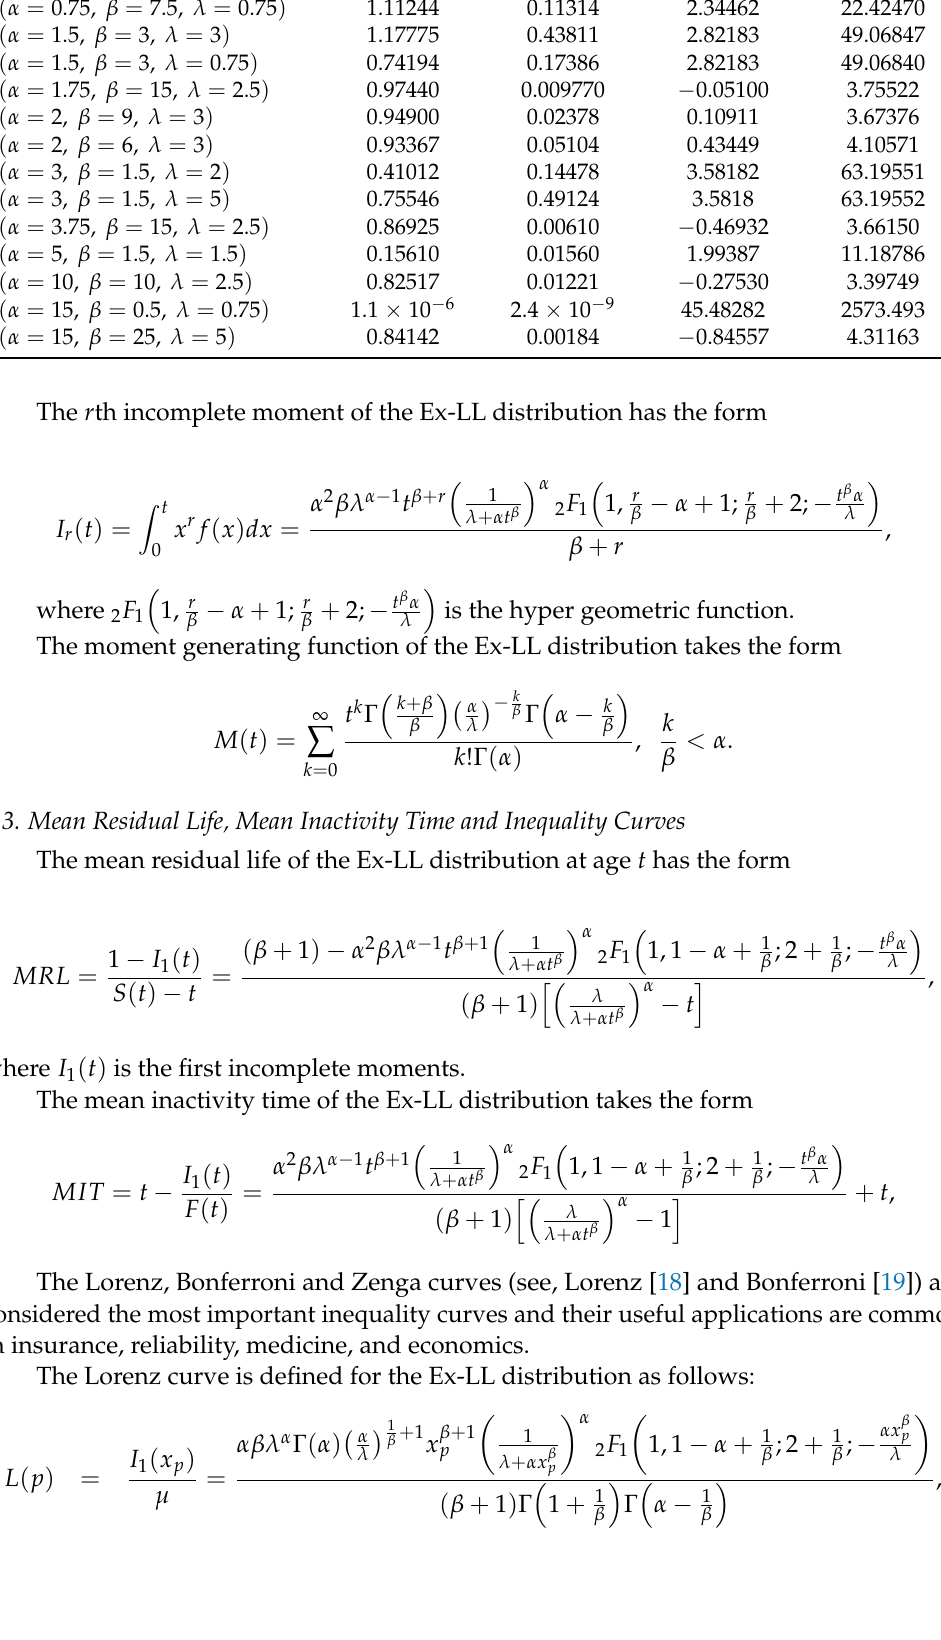
, Var ( X ) , γ 1 ( X ) , and γ 2 ( X ) of the Ex-LL distribution for several 1